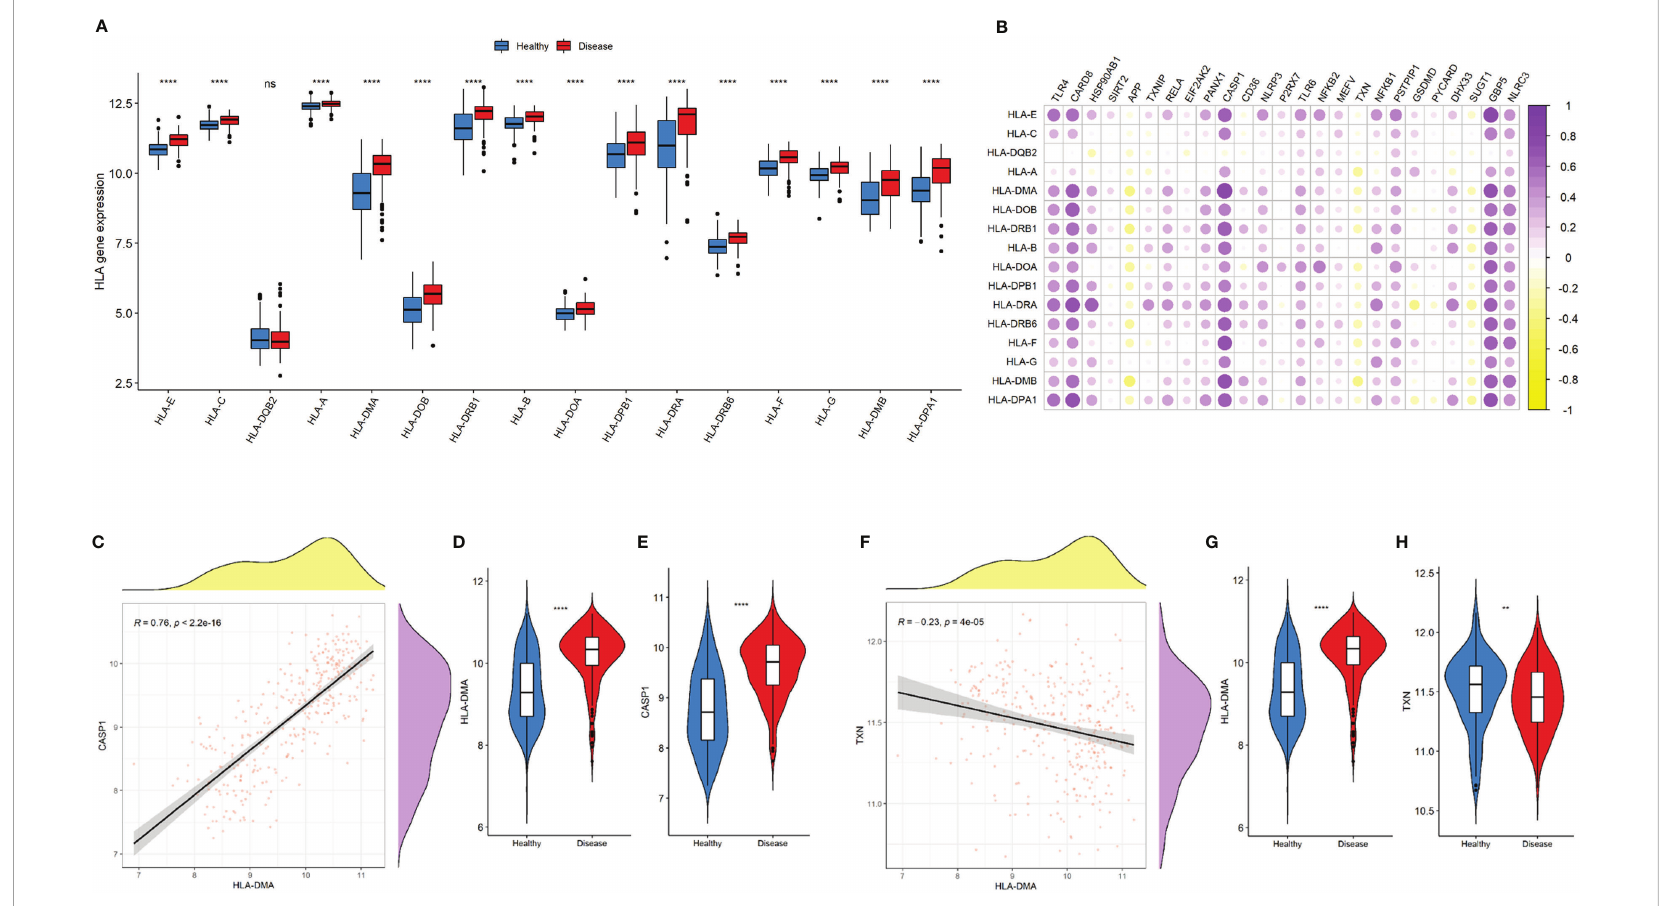
FIGURE 7 NLRP3 in fl ammasome-related genes and HLA-related genes. (A) Comparison of HLA-related gene expressions between the two groups. (B) Correlation plot showing signi fi cant correlations between the NLRP3 in fl ammasome- and HLA-related genes. Purple: positive correlation. Yellow: negative correlation. Circles with deeper colors indicate stronger correlations. (C) Correlation between CASP1 expression and antigen processing and presentation pathway. (D, E) Violin plots showing the expressions of HLA-DMA (D) and CASP1 expression (E) in two groups. (F) Correlation between TXN and HLA-DMA expressions (G-H) Violin plots showing the expressions of HLA-DMA (G) and TXN (H) in two groups. R represents Pearson correlation coef fi cients. ns: P ≥ 0.05; ** P ≤ 0.01; **** P ≤